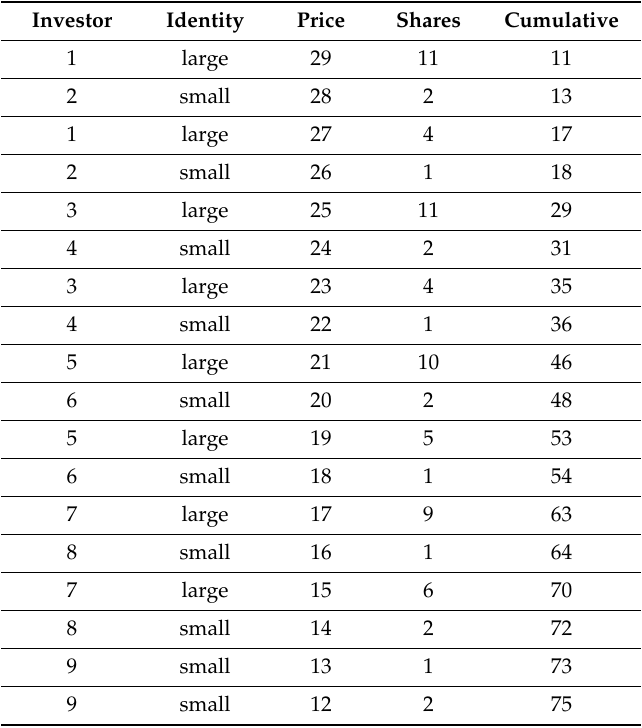
Table 2. Illustrative subject auction